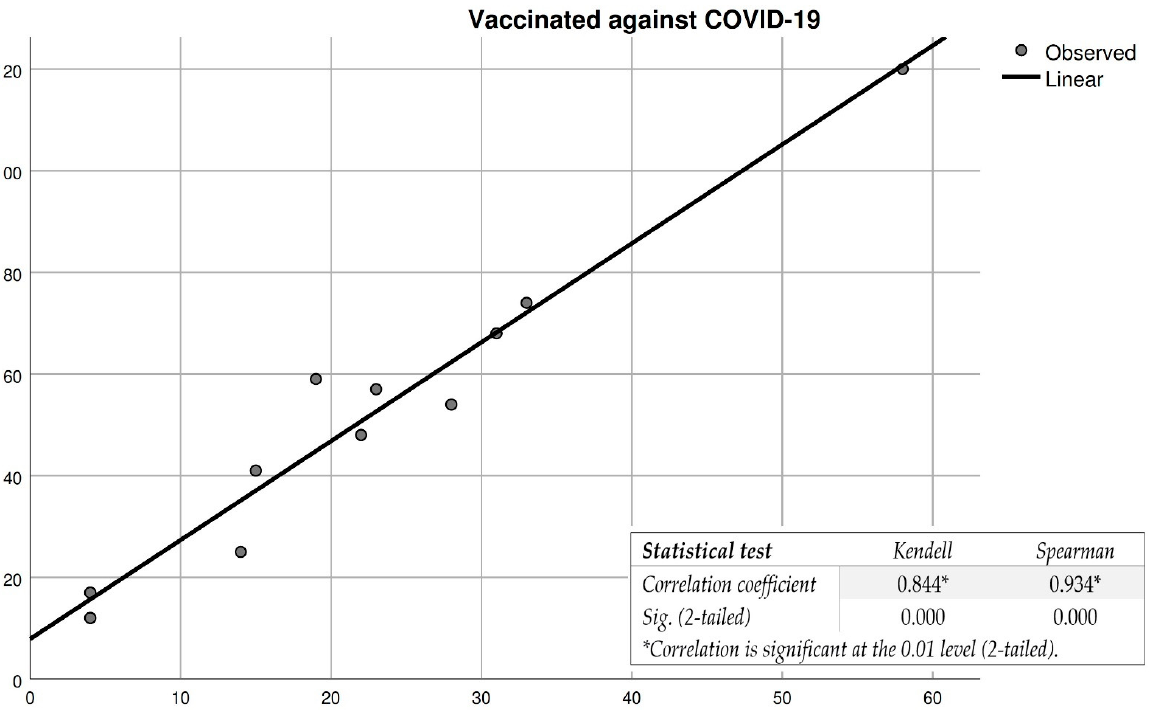
Figure 3. Correlation between participants’ vaccination against COVID-19 and their decision to vaccinate against monkeypox. * For a correlation to be very strong, the correlation coefficient must be as close as possible to 1, and sig. as close as possible to 0. With regard to the second part of the questionnaire (Table 8), it should be noted that in question Q1, 47.1% of the respondents agree that monkeypox is a real problem in to- day’s society. For questions Q2–Q6 (which can be classified as “fake news” information regarding the monkeypox disease), 55.8% and 64.3% of the respondents disagree and 21.7% and 28.9% out of the respondents agree with the allegations, respectively. Correla- tion tests also show a clear link between the decision to vaccinate and confidence in “fake news” claims, as shown in Figure 4. In this situation, we observed that participants who place a high degree of trust in conspiratorial “fake news” information have an extremely low degree of acceptance of the monkeypox vaccine inoculation. Such situations are also observable in studies dealing with the acceptance of COVID-19 vaccines [22,23].